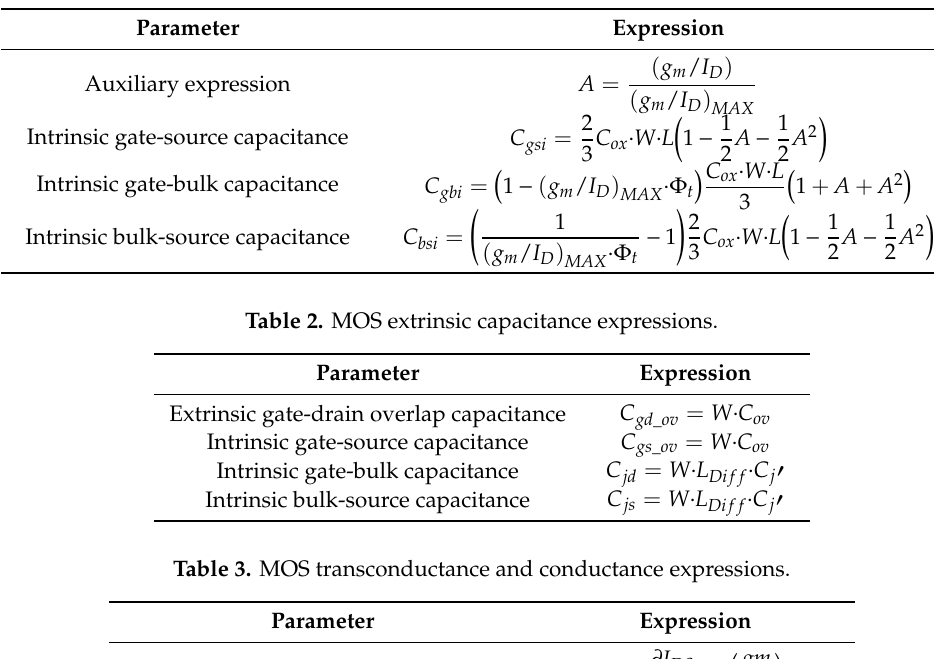
Table 1. MOS intrinsic capacitance expressions.